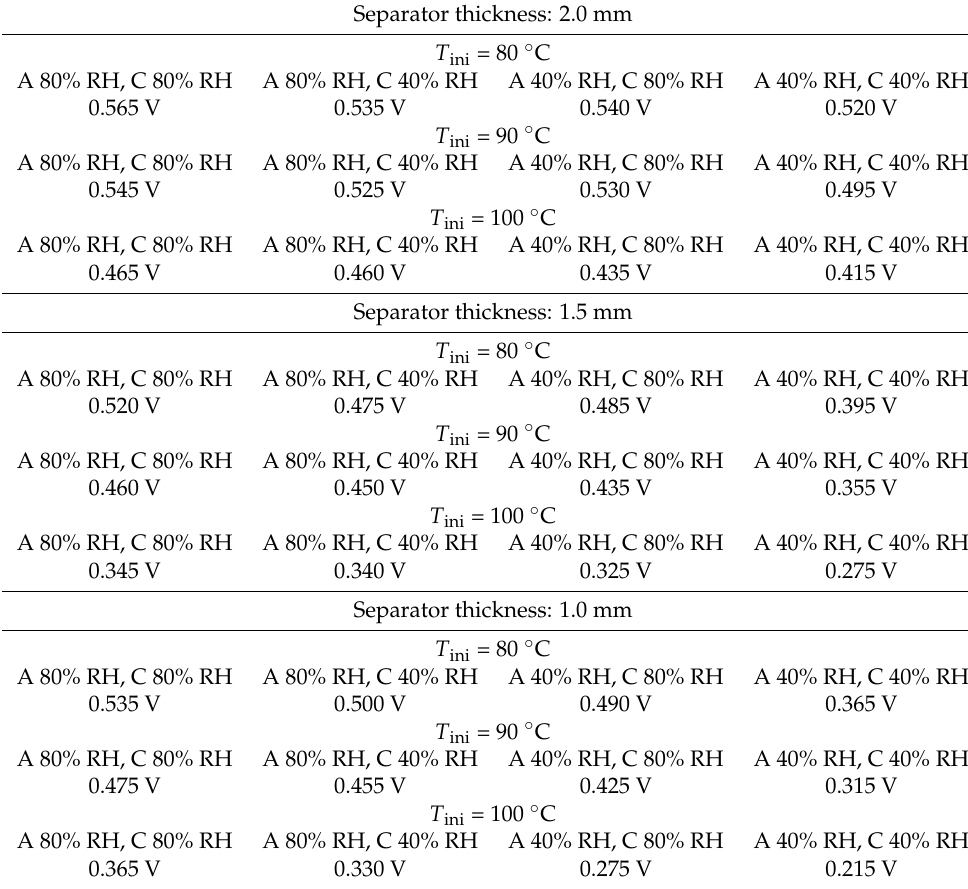
Table 3. Experimental data on power-generation performance, at load current of 20